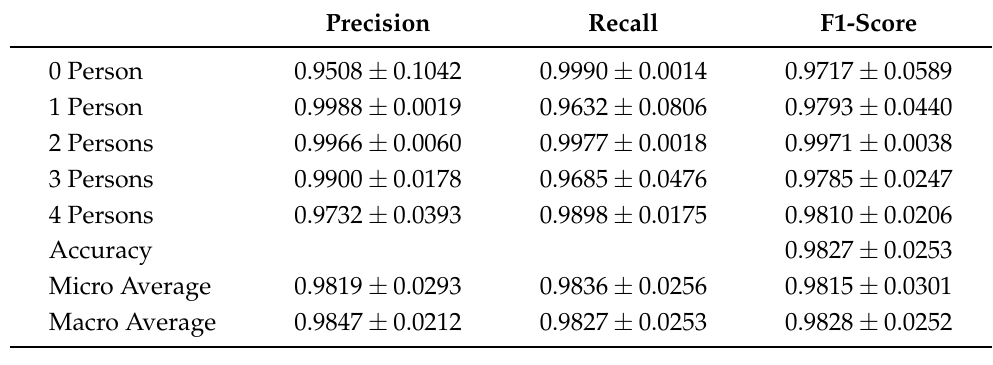
Table 4. Classification performance of the DNN. The average and standard deviation (stdev) for each metric are calculated using results from the 5-fold cross-validation.